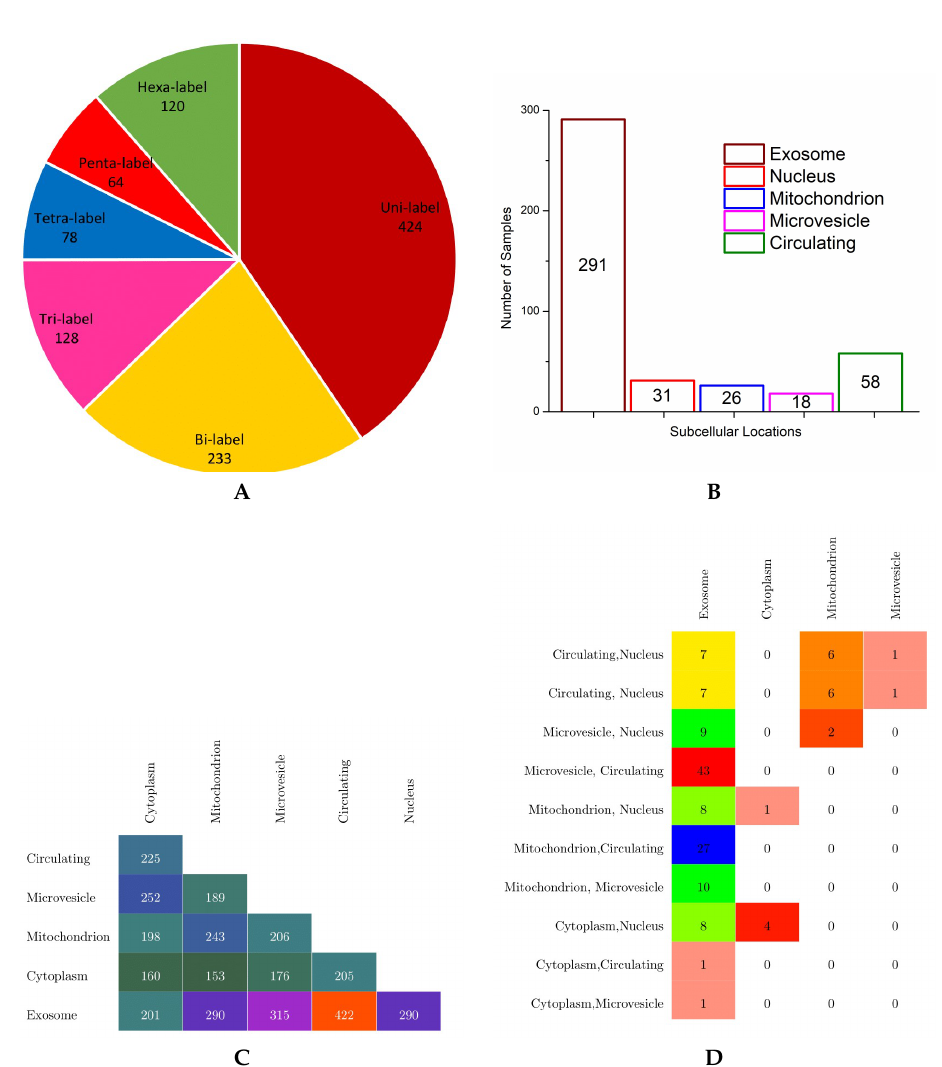
Figure 4. Statistics of the benchmark dataset: ( A ) distribution of miRNA sequences with respect to the number of labels, ( B ) the total number of miRNA sequences solely belonging to each subcellular location, ( C ) non-sparse bi-label confusion matrix, and ( D ) non-sparse tri-label confusion